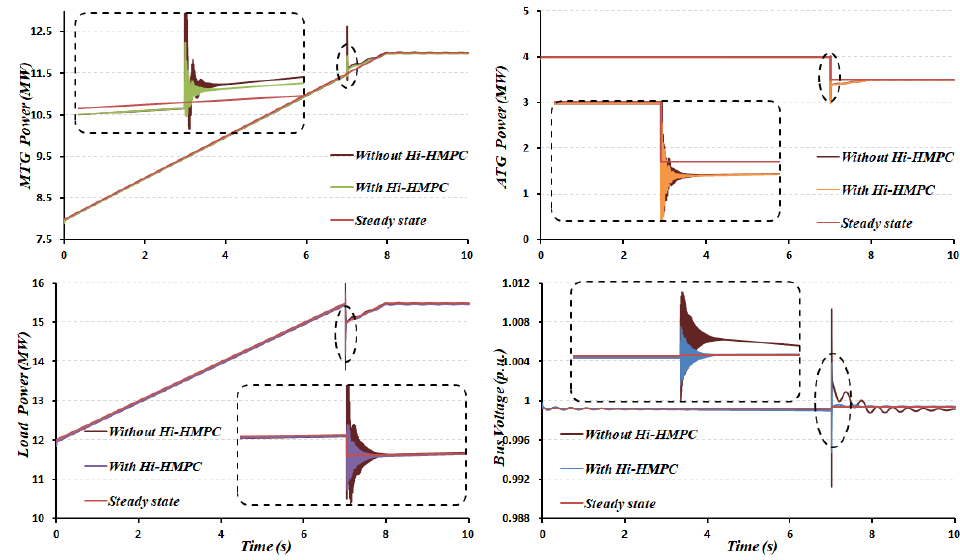
Figure 8. Performance demonstration of Hi-HMPC in real time simulation of scenario